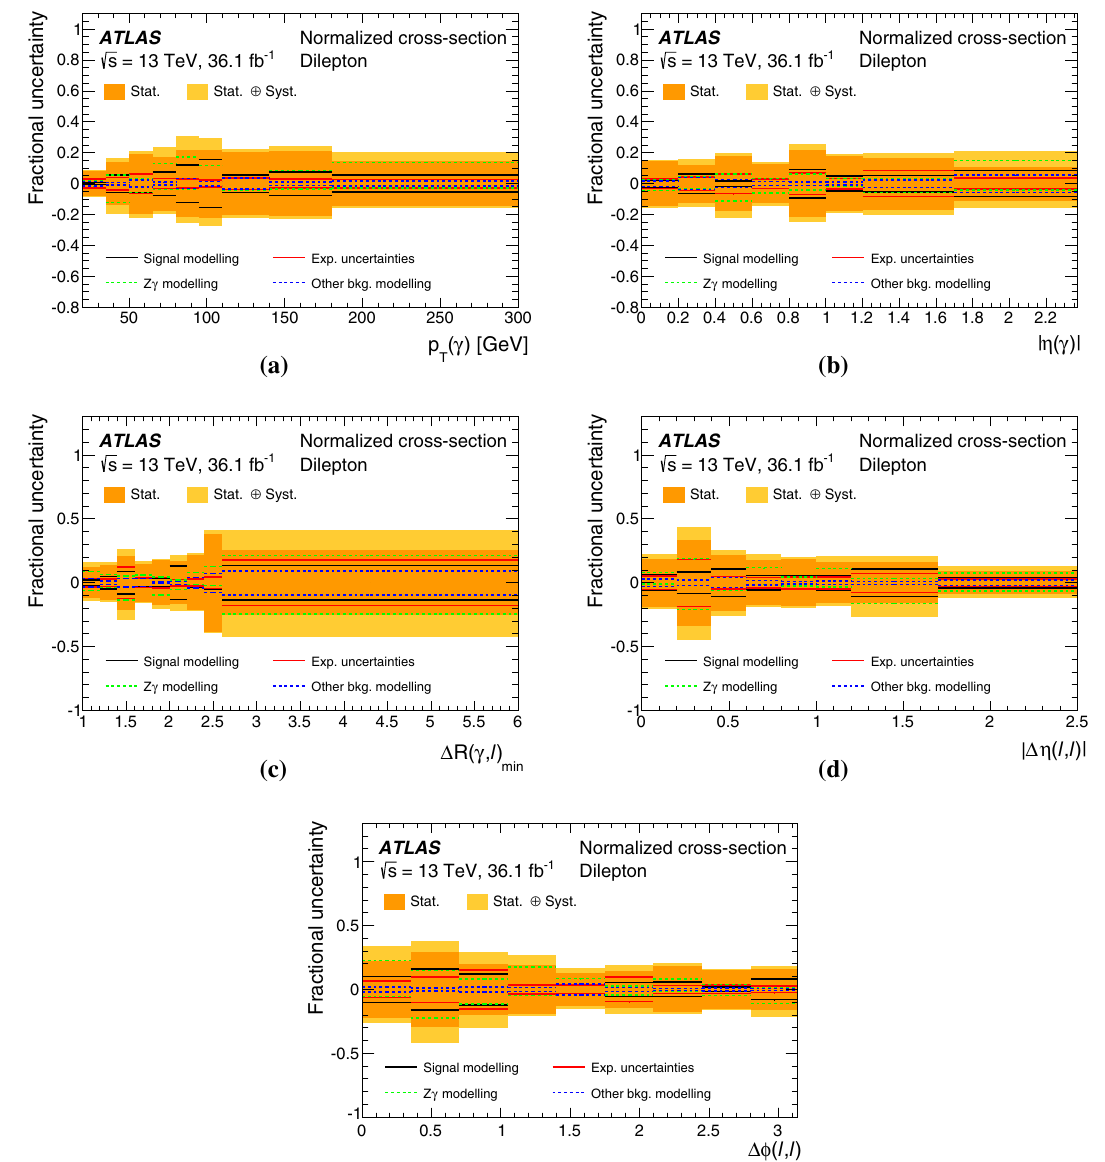
Fig. 12 The decomposed systematic uncertainties for the normalized differential cross-sections as a function of the a photon p T , b photon | η | , c minimum (cid:7) R (γ,(cid:8)) , d | (cid:7)η((cid:8),(cid:8)) | , and e (cid:7)φ((cid:8),(cid:8)) in the dilepton channel